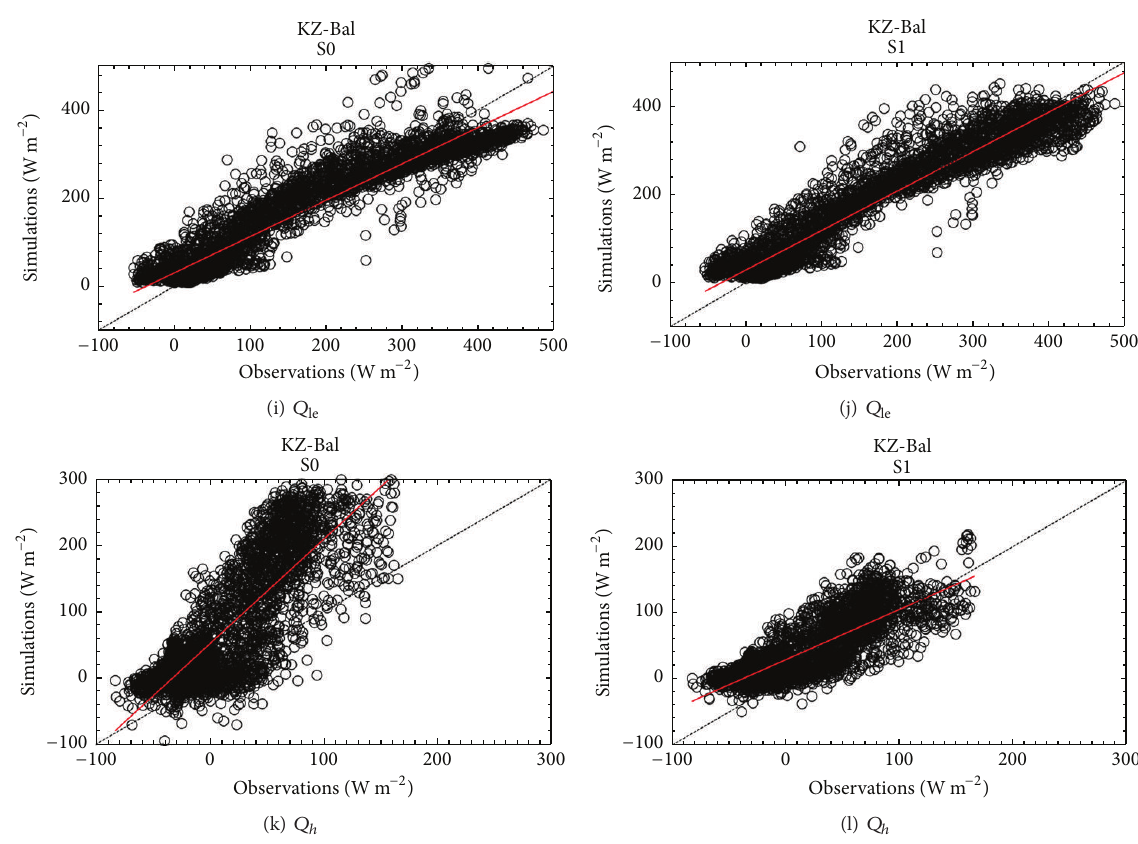
Figure 3: Comparison between the measured half-hourly net radiation ( 𝑅 net ), latent heat flux ( 𝑄 le ), and sensible heat flux ( 𝑄 ℎ ) and the values simulated by the reference model (S0) and the model with refined roughness length (S1) at the KZ-Ara and KZ-Bal sites. The solid red line represents the linear regression between the simulation and the observed data, and the dashed line represents a 1:1 relationship between the datasets.